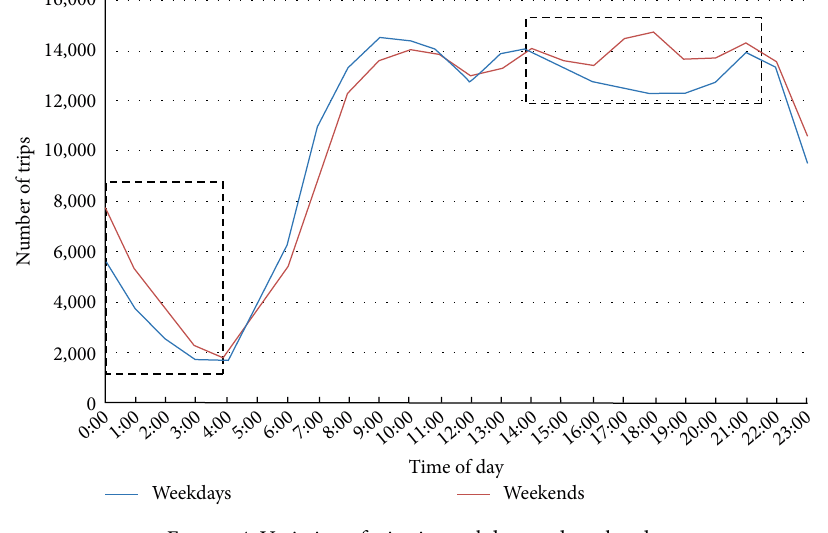
Figure 4: Variation of trips in weekdays and